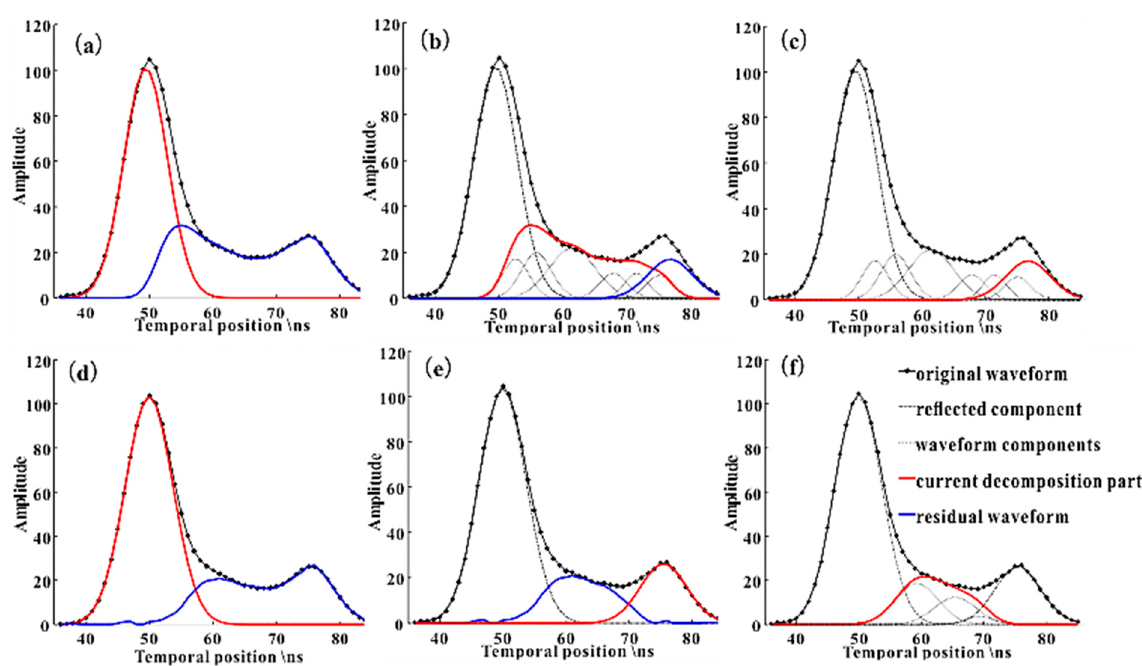
Figure 12. Process comparison ( a – c ) is the decomposition process of the GHPD method; ( d – f ) is the decomposition process of the CGD method).